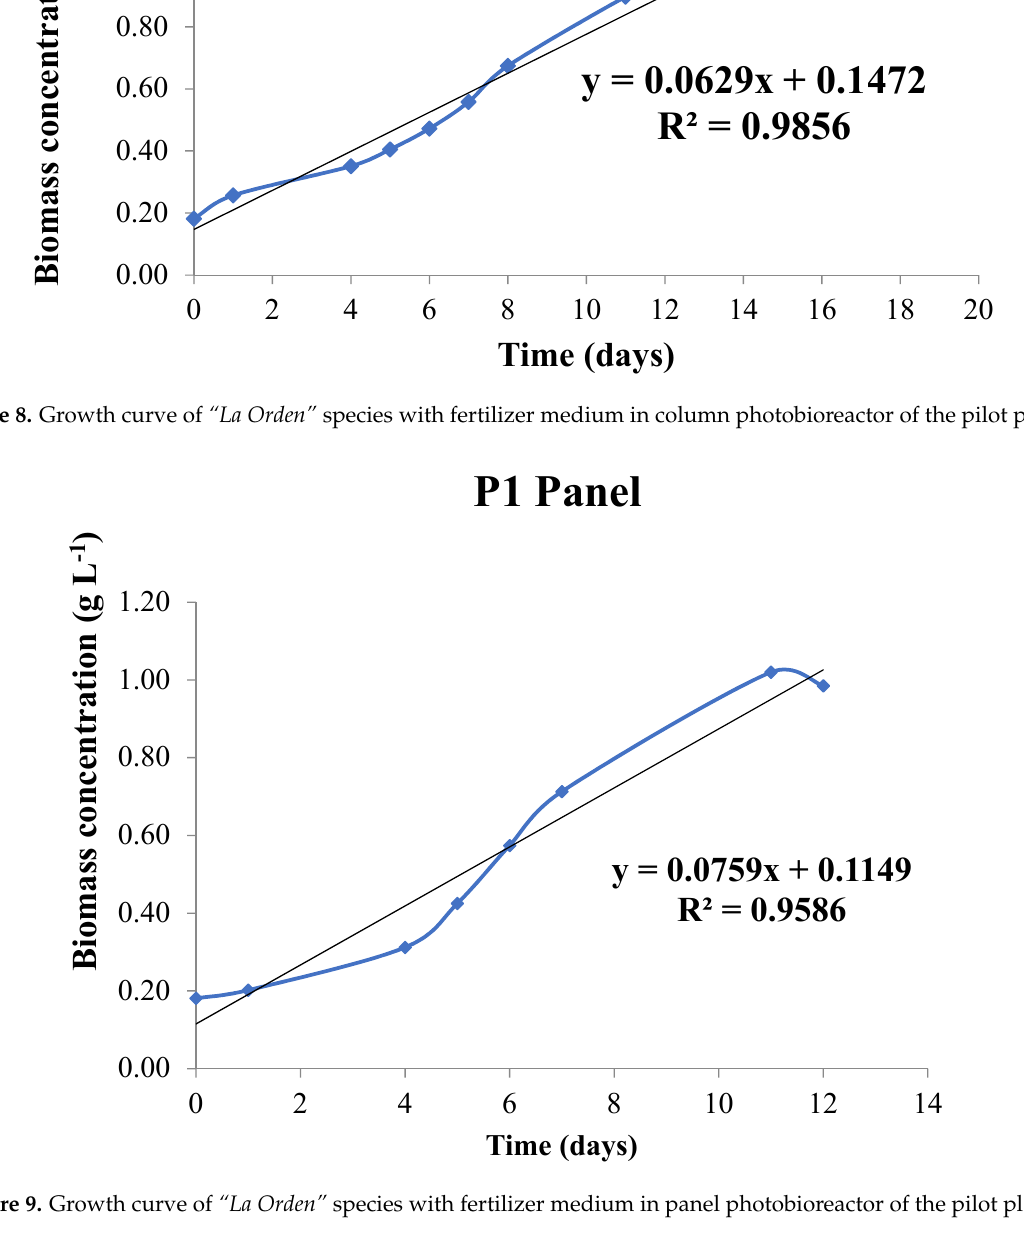
y = 0.0629x + 0.1472 R² = 0.9856